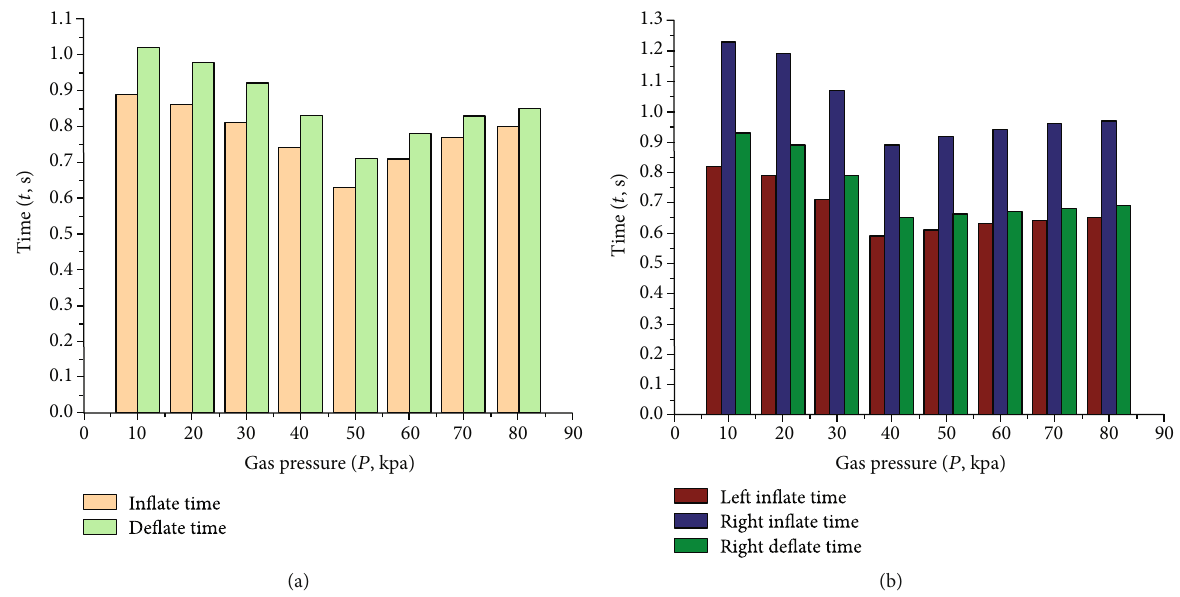
Figure 12: Motion cycle sequence diagrams of pneumatic soft-bodied bionic actuator. (a) Middle part bending motion cycle of actuator. (b) Left and right side bending motion cycle of